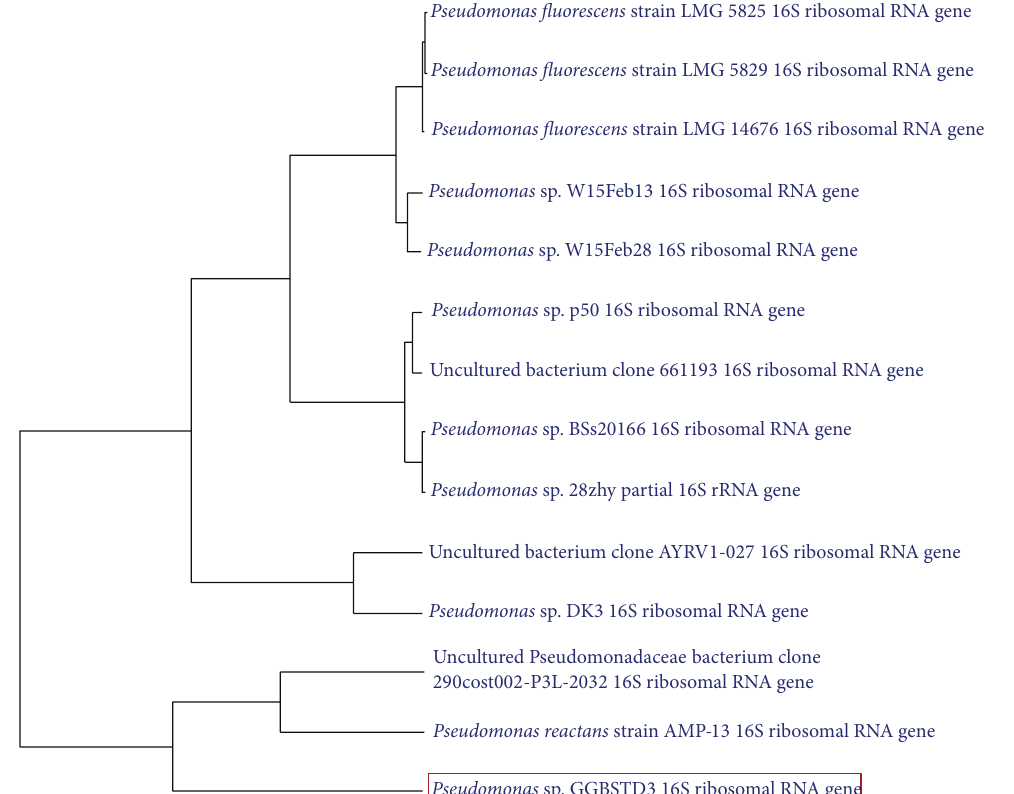
Figure 2: Neighbor joining phylogenetic tree of full 16S rRNA gene sequences showing the relationship among Pseudomonas spp. GGBSTD3 and representatives of some related taxa. The sequence data for several closely related Pseudomonas cultures were recovered from GenBank and included in the